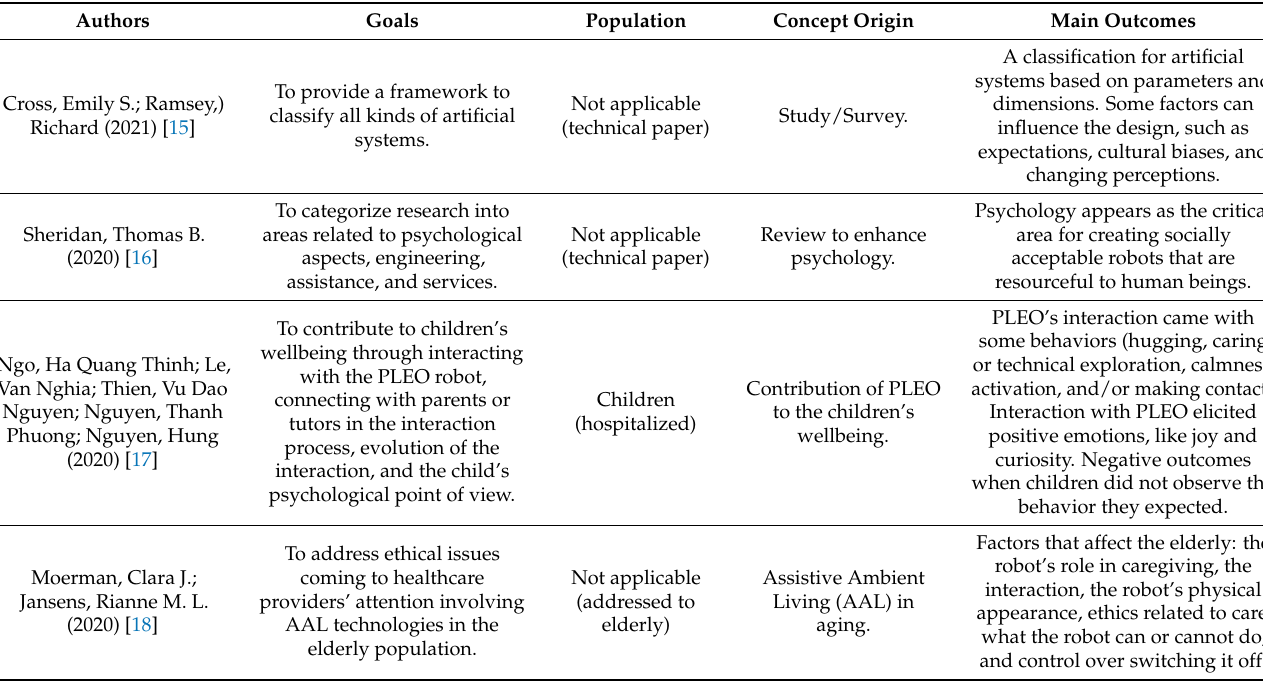
Table 3. Research question 1 (RQ1) on design approaches and main outcomes.